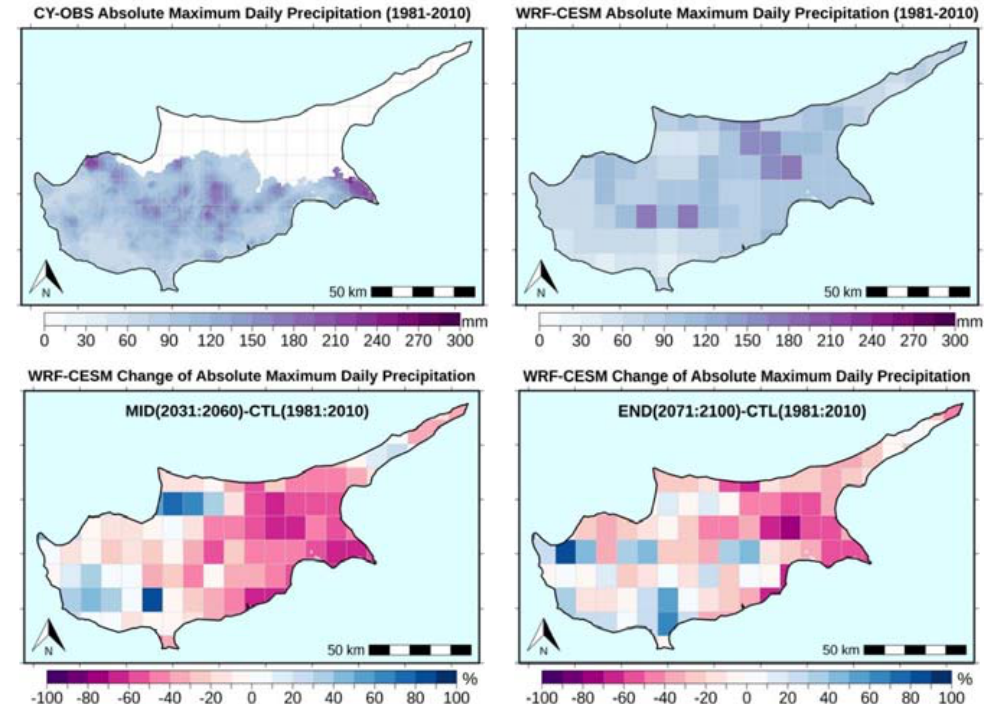
Figure 11. Observed ( top left ) and simulated ( top right ) absolute maximum daily precipitation per sub-period (RXa) for the period 1981 to 2010 and projected changes (%) for the middle ( bottom left ) and end of the 21st century ( bottom right ).